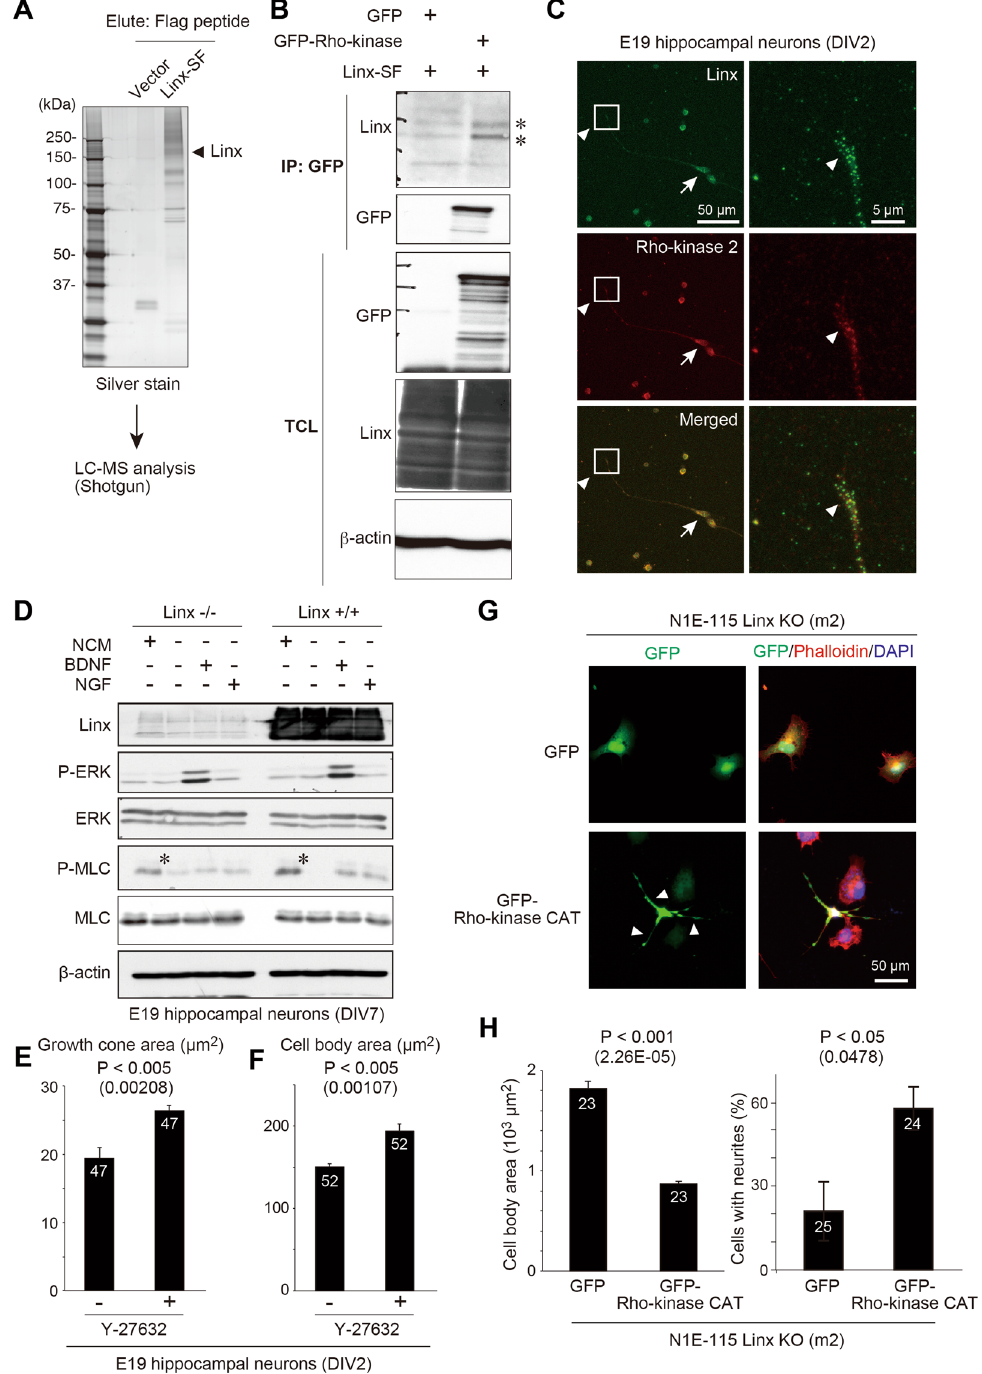
Figure 6. Identification of Rho-kinase as a Linx-interacting protein. (A) Representative silver staining of Linx-SF-interacting proteins in 293FT cells isolated by IP. (B) 293FT cells were transfected with Linx-SF (streptavidin-Flag) and either GFP or GFP-Rho-kinase, followed by IP using a GFP antibody and Western blot analysis. Asterisks denote co-immunoprecipitated Linx. Full blot images are shown in Supplementary Figure S3. (C) Colocalization of endogenous Linx and Rho-kinase at the tips of growth cones (arrowheads) and cell bodies (arrows) of primary cultured hippocampal neurons. Boxed areas were magnified in adjacent panels. (D) Linx regulates the activity of Rho-kinase. Hippocampal neurons isolated from the brain of Linx − / − (left) and Linx + / + (right) mice at E19 were incubated in a conventional neuron culture medium (NCM) or starved followed by stimulation with either BDNF, or NGF. Lysates from the neurons were analyzed by Western blot analysis with the indicated antibodies. Note that MLC was more highly phosphorylated in Linx + / + neurons than Linx − / − neurons when cultured in NCM (asterisks). Full blot images are shown in Supplementary Figure S3. (E , F) Primary cultured hippocampal neurons were isolated from E19 embryo and cultured in the presence or